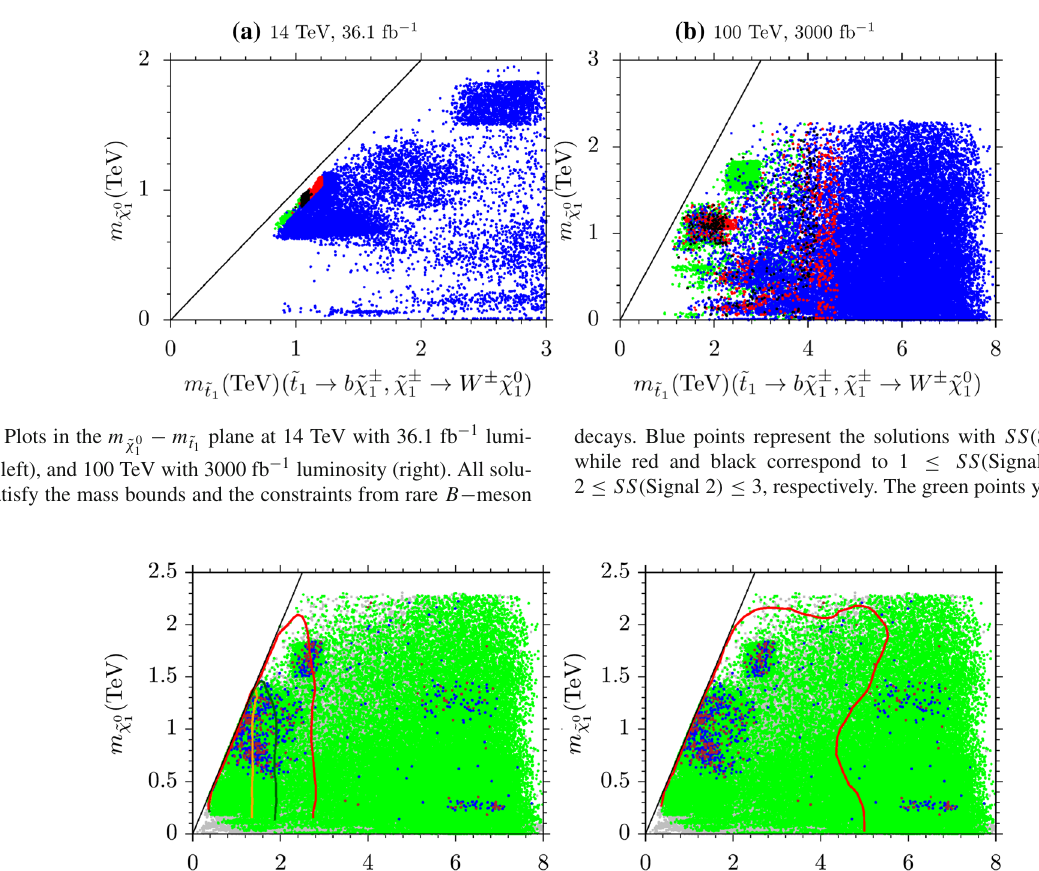
TeV and 100 TeV, repsectively. Luminosity is set to 36 . 1 fb − 1 1 at all energies. The right panel is the same exclusion curve for the stop mass at 100 TeV center of mass energy and 3000 fb − 1